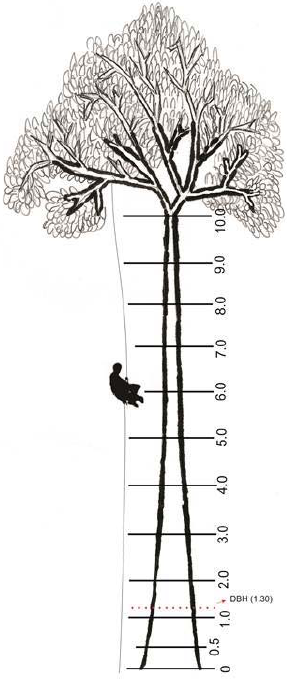
Figure 2. Samples trees of Eschweilera genus measured with climbing techniques using ropes.